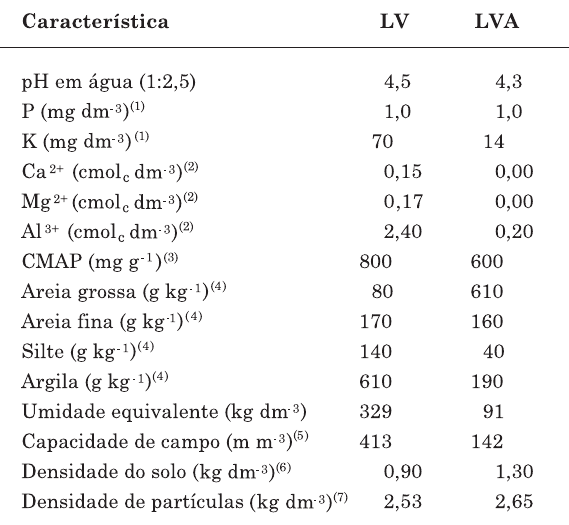
do da coluna (Fernandes, 1967). (6) Método do anel volumétrico. (7) Método do balão